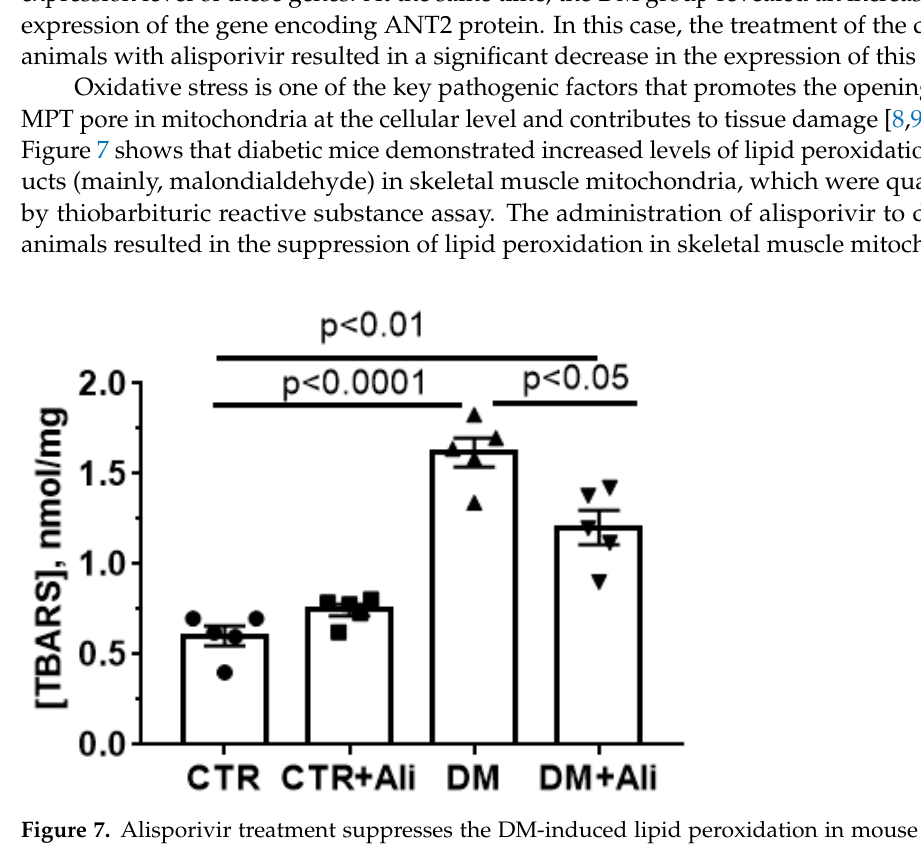
Figure 7. Alisporivir treatment suppresses the DM-induced lipid peroxidation in mouse skeletal muscle mitochondria. Lipid peroxidation was assessed by the level of TBARS in the skeletal muscle mitochondria of the experimental animals. All data are mean ± SEM ( n = 5).